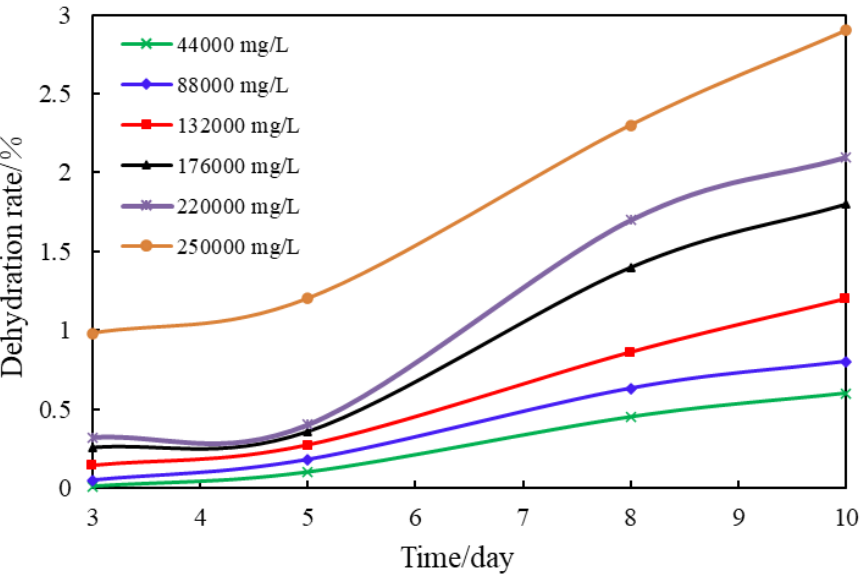
Figure 9. Effects of Salinity on the Gel Dehydration Rate.